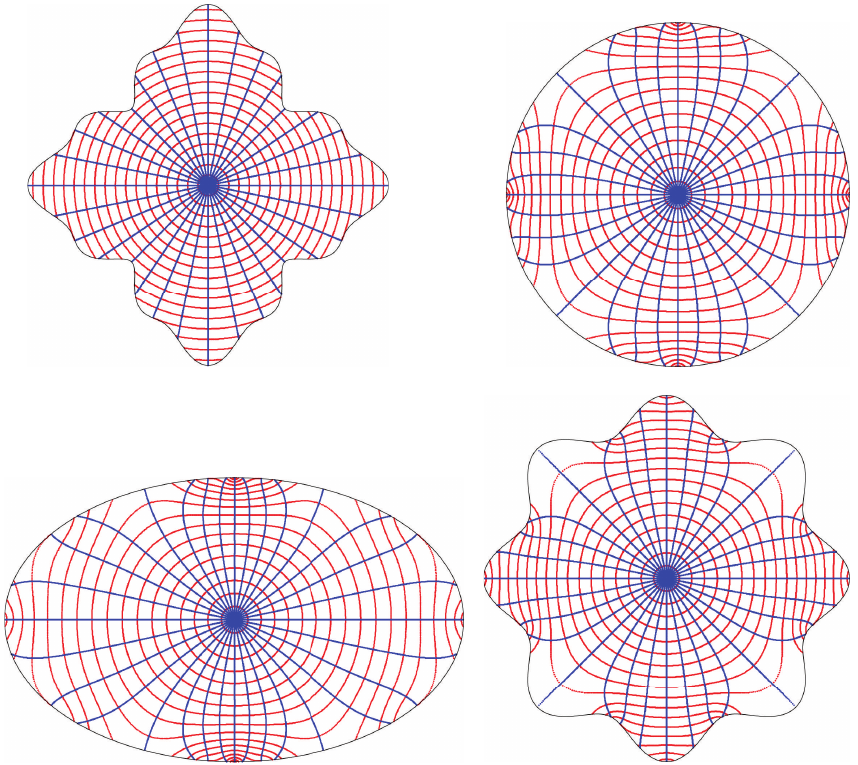
Figure 1: The conformal mappings from 𝐺 1 onto Ω 1 , Ω 2 , and Ω 3 .